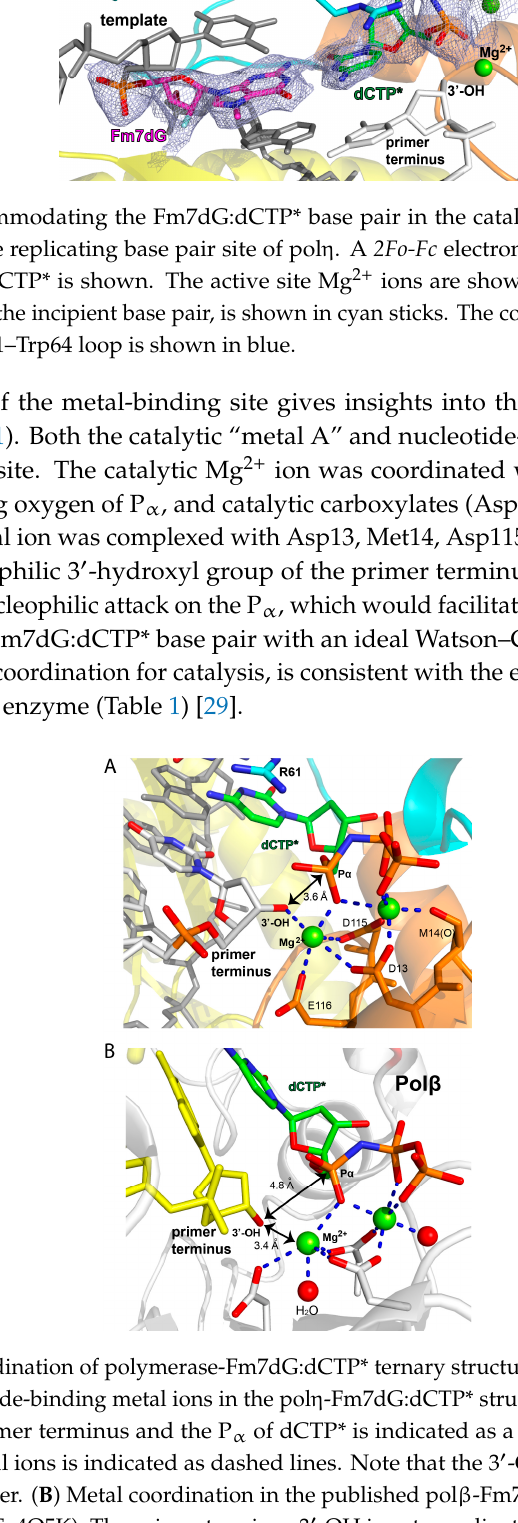
4.8 Å away from the P α of dCTP*, and poorly positioned for in-line nucleophilic